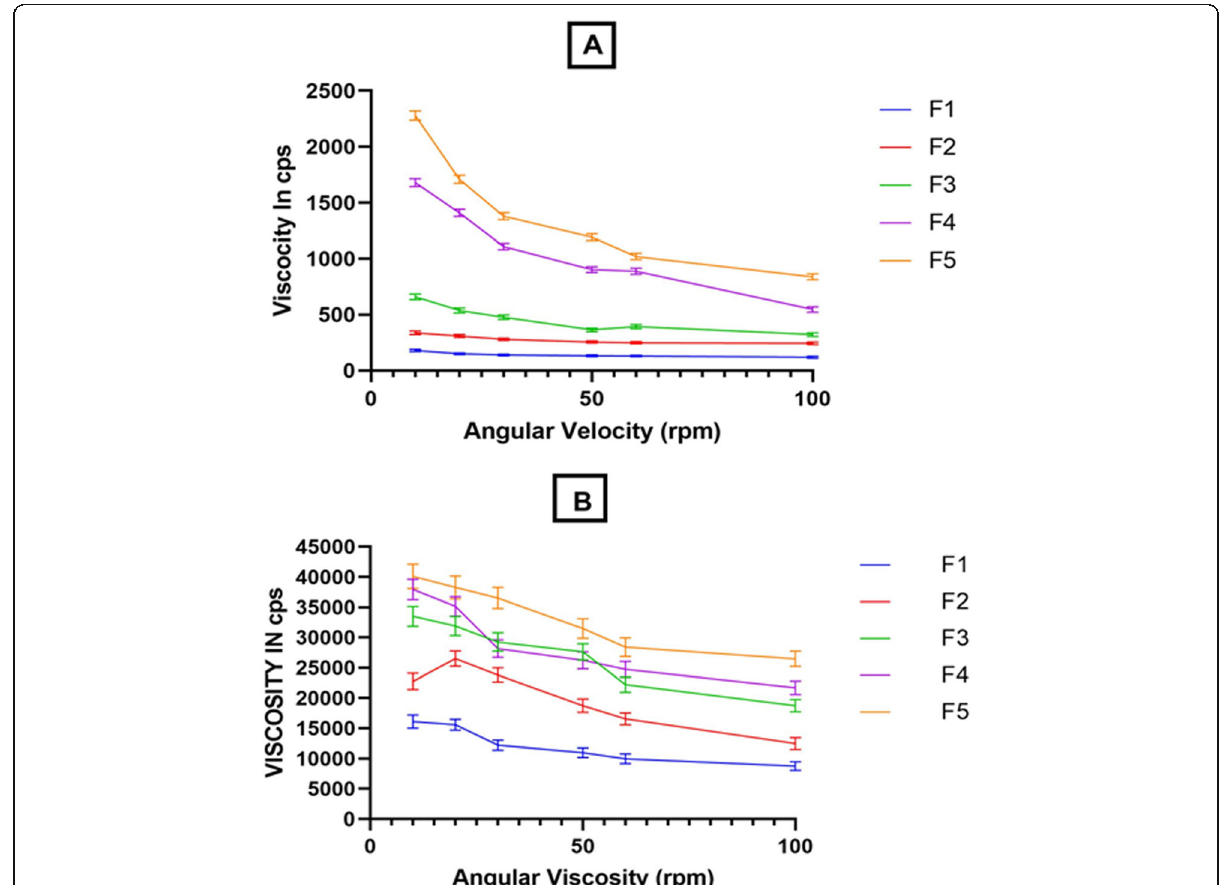
Fig. 6 Viscosity of camptothecin herbal gel a before gelation and b after